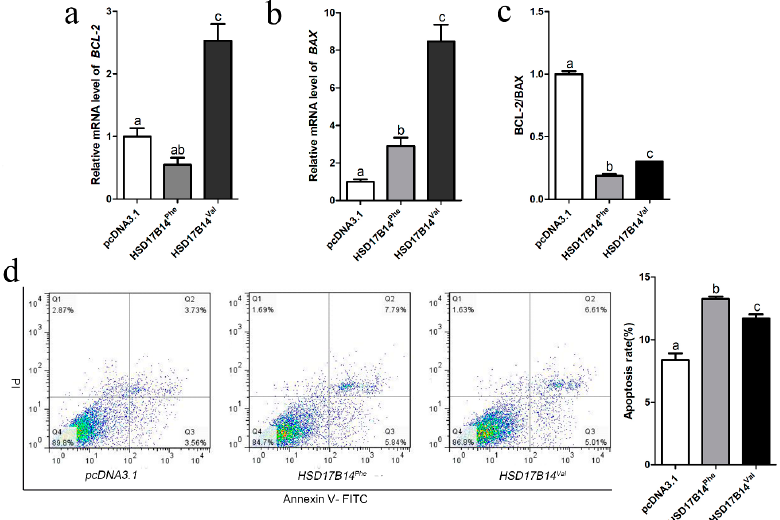
Figure 5. Effect of overexpression of the porcine HSD17B14 gene Phe73Val on apoptosis of ovarian granulosa cells (GCs). ( a , b ) RT-qPCR analyses of BCL-2 and BAX mRNA expression in porcine GCs transfected with HSD17B14 Phe , HSD17B14 Val or pcDNA3.1 (+ ). The mRNA levels were normalized to GAPDH . ( c ) BCL-2/BAX ratio. ( d ) Fluorescence-activated cell sorting (FACS) analyses of the apoptosis rates of porcine GCs when HSD17B14 Val and HSD17B14 Phe were overexpressed. Each experiment was repeated three times and data are shown as means ± S.E.M. p -values were calculated by t -test, different letters (a, b and c) indicate that the difference is significant ( p < 0.05).